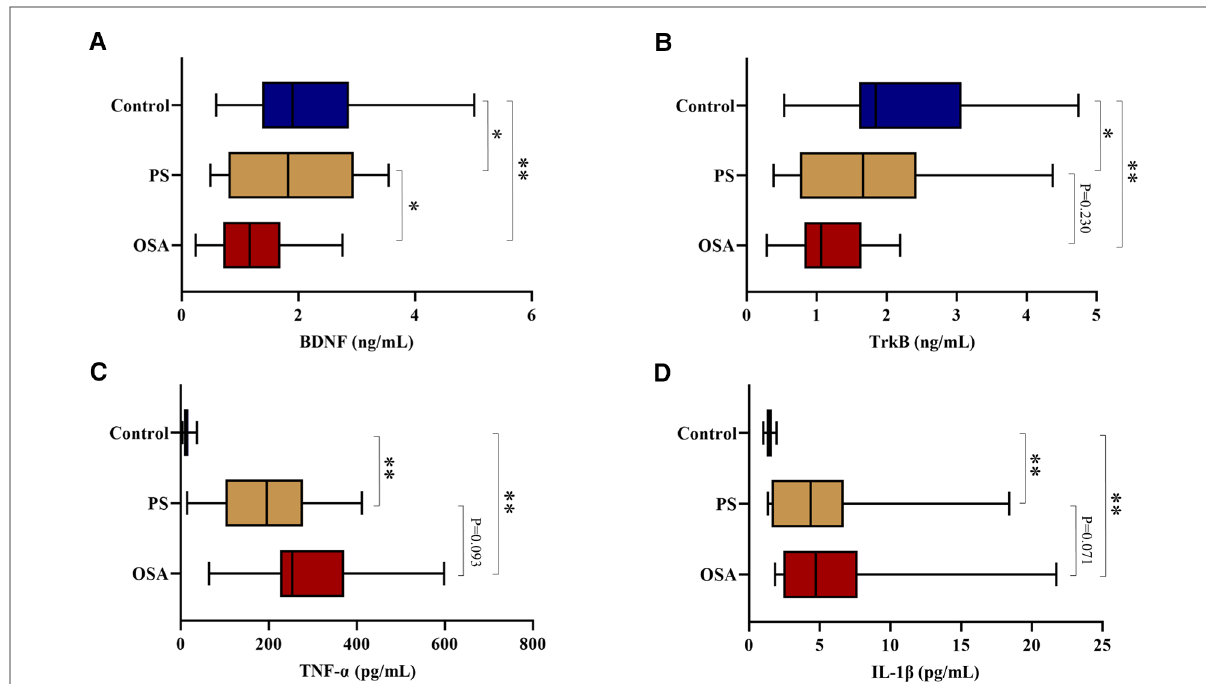
FIGURE 2 ( A ) Comparison of serum BDNF levels among three groups; ( B ) Comparison of serum TrkB levels among three groups; ( C ) Comparison of serum TNF- α levels among three groups; ( D ) Comparison of serum IL-1 β levels among three groups. ** P <0.01, * P <0.05. BDNF, brain-derived neurotrophic factor; TrkB, tyrosine kinase receptor B; IL-1 β , interleukin-1beta; TNF- α , tumor necrosis